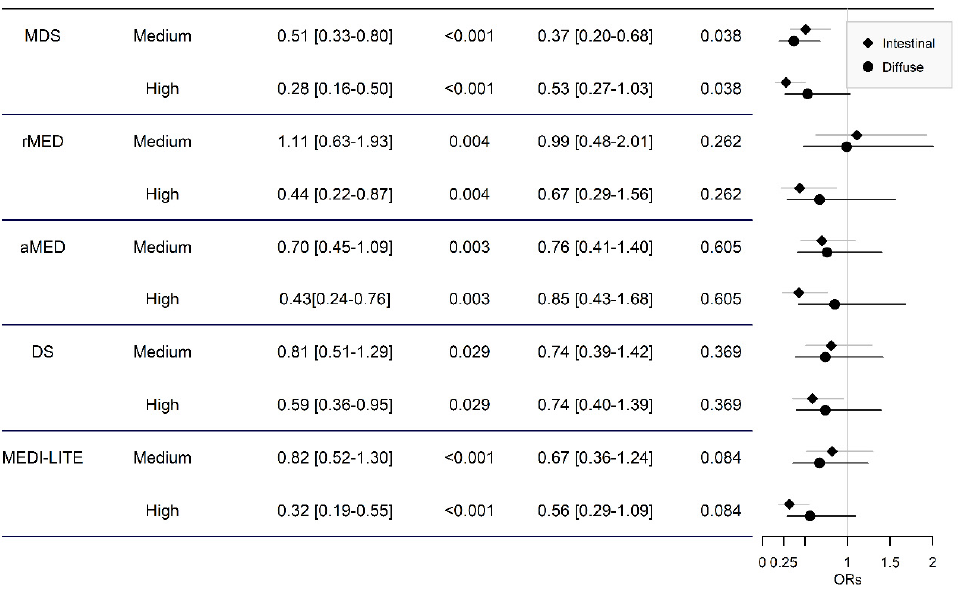
Figure 3. Odds ratios of risk of intestinal and diffuse adenocarcinoma according to adherence level to various indexes compared with low adhesion.